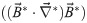
Volume averaged modulus of some components of the vector ((B→*·∇→*)B→*).(A) the lateral position (see Fig 1A) (B) the centered position (see Fig 1B). The continuous lines correspond to the volume averaged modulus of the vertical component (i.e. |(B→*·∇→*)Bz*|) and the dashed line contours to the modulus of the vector defined by the sum of the vertical and lateral components, [((B→*·∇→*)Bz*)2+((B→*·∇→*)Bx*)2]1/2.